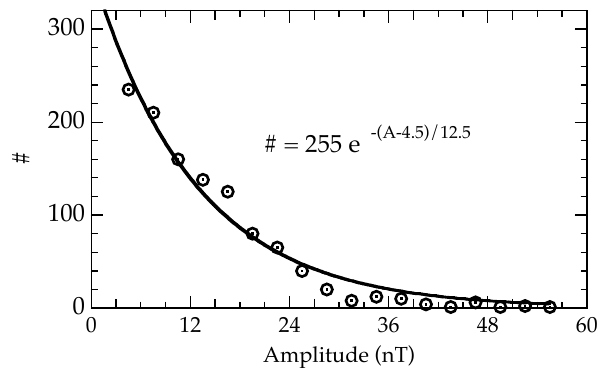
Fig. 4. Dots indicate the distribution of FTEs versus amplitude (in nT) observed by Cluster on the high-latitude and flank mag- netopause (Wang et al., 2005). The solid curve shows a fit to the